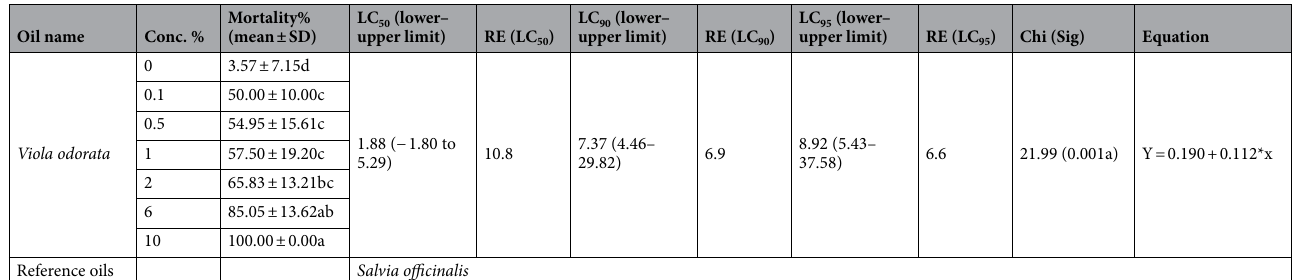
Table 6. The adulticidal effects of selected plant oils against Culex pipiens after 24 h post-treatments.